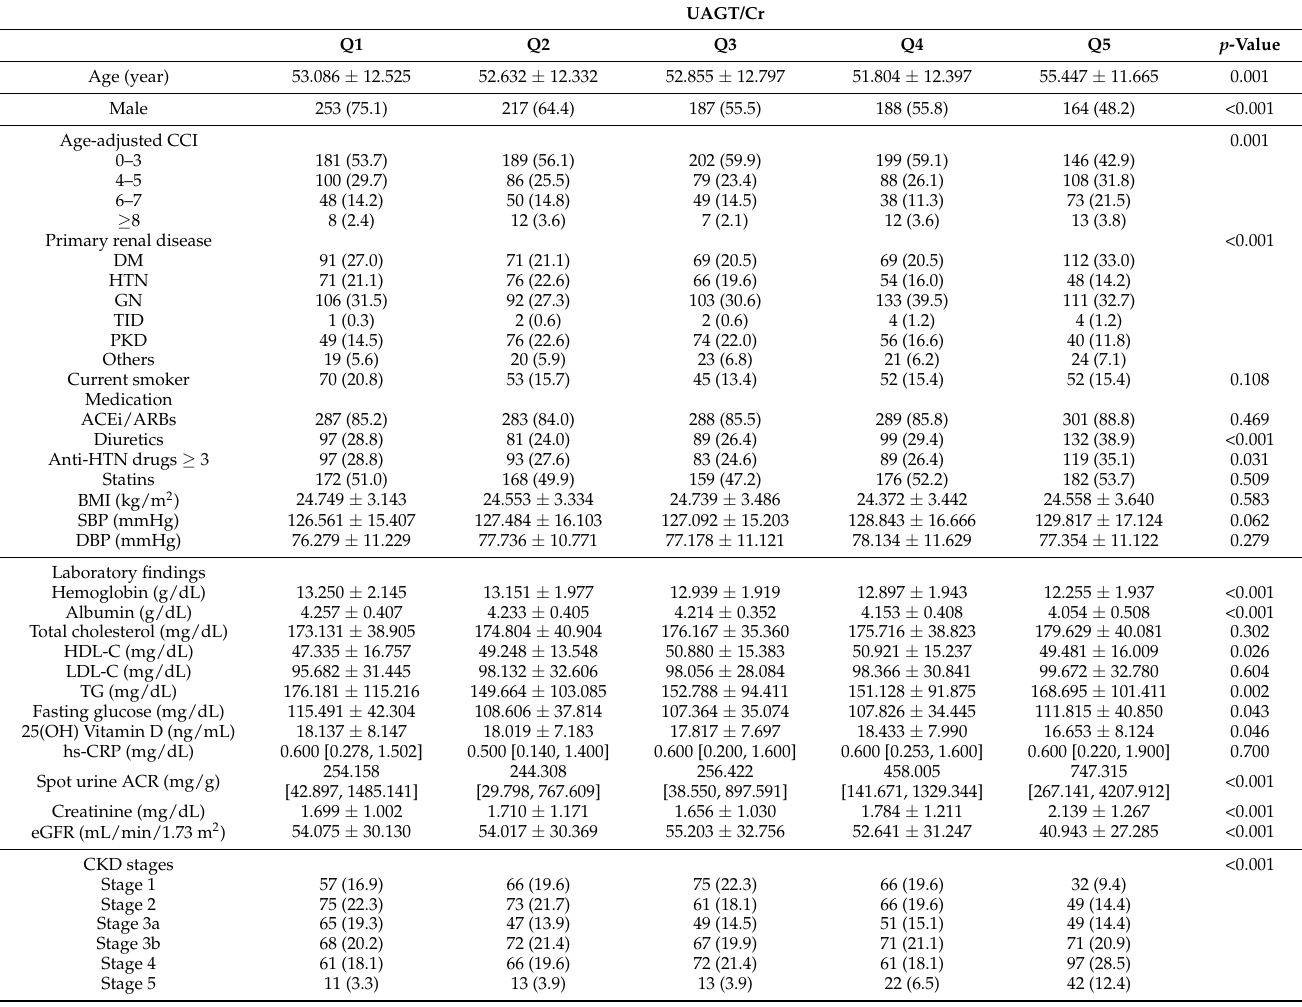
Table 1. Baseline characteristics of study participants by